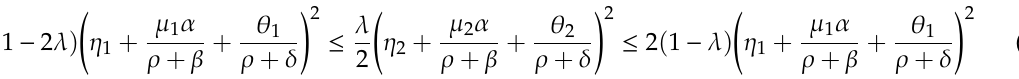
1 = 0.4, μ 2 = 20, and G = 0 0